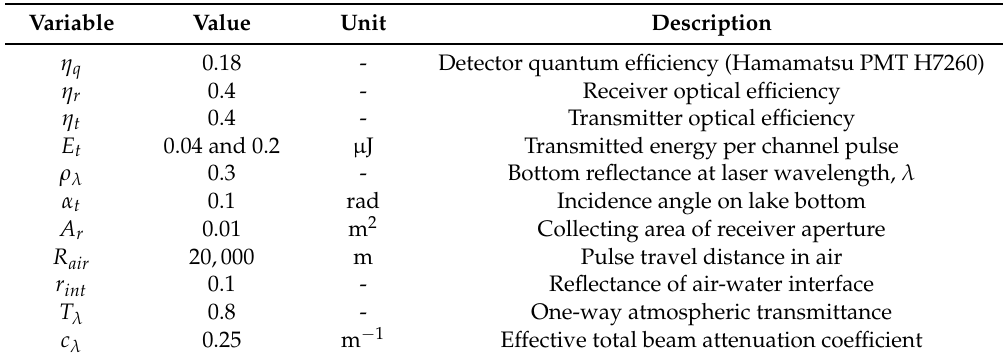
Table 2. Parameter values used in a photon-counting version of the lidar equation to predict the number of photon returns from the bottom. Parameter values are purposefully stated with variable precisions, which reflect our relative level of knowledge of each.